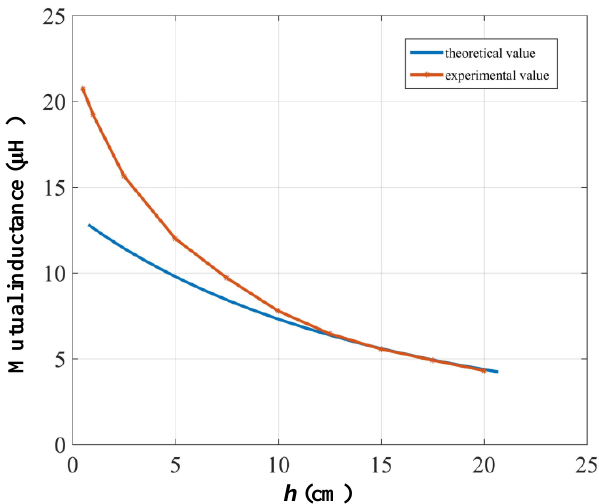
Figure 12. Mutual inductance in theory and experiment.